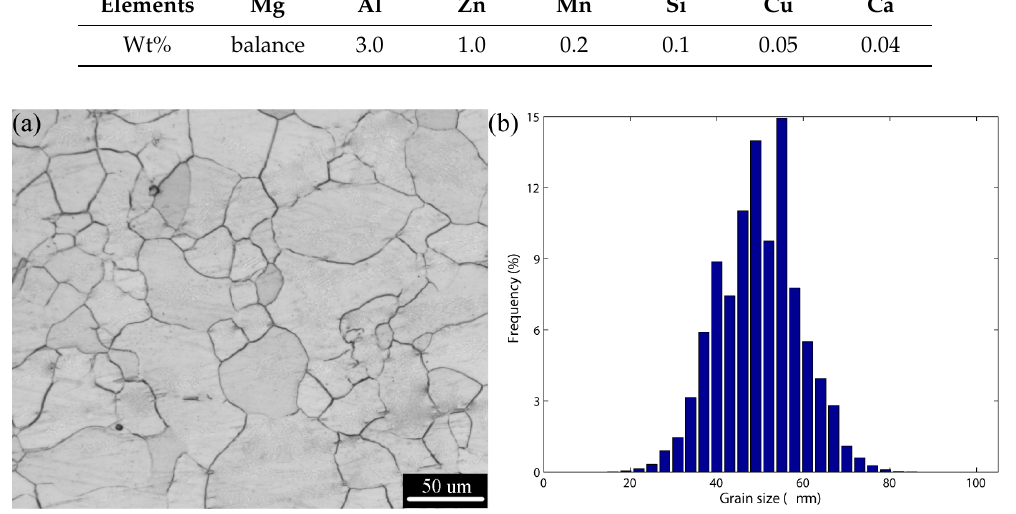
Figure 1. ( a ) Initial microstructure of AZ31B; ( b ) grain size distribution of initial AZ31B.